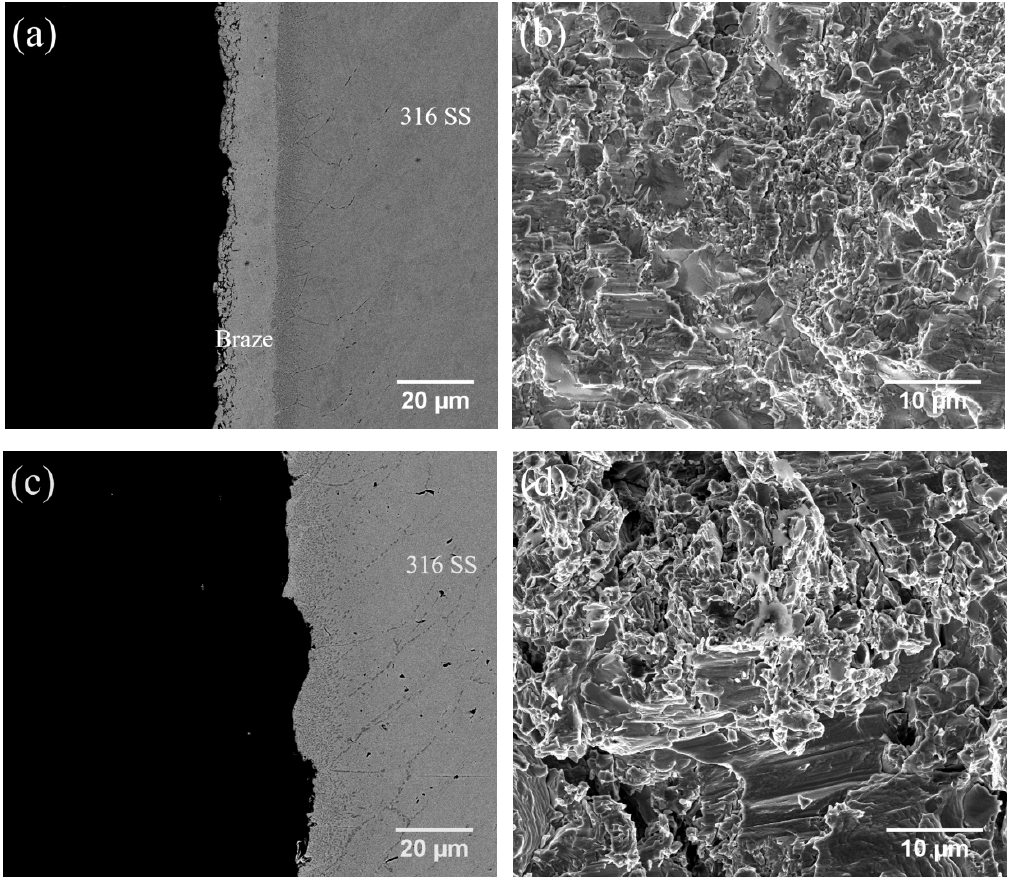
Figure 11. SEM ( a ) cross-section and ( b ) fractograph of joint infrared brazed at 1020 °C for 180 s, ( c ) cross-section and ( d ) fractograph of CoCrFeNi/BNi-2/316 SS joint infrared brazed at 1050 °C for 600 s.